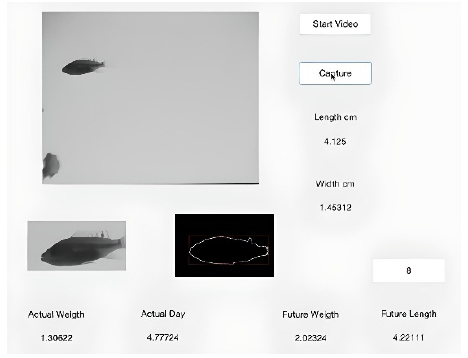
Figure 14. Interface and the algorithm.